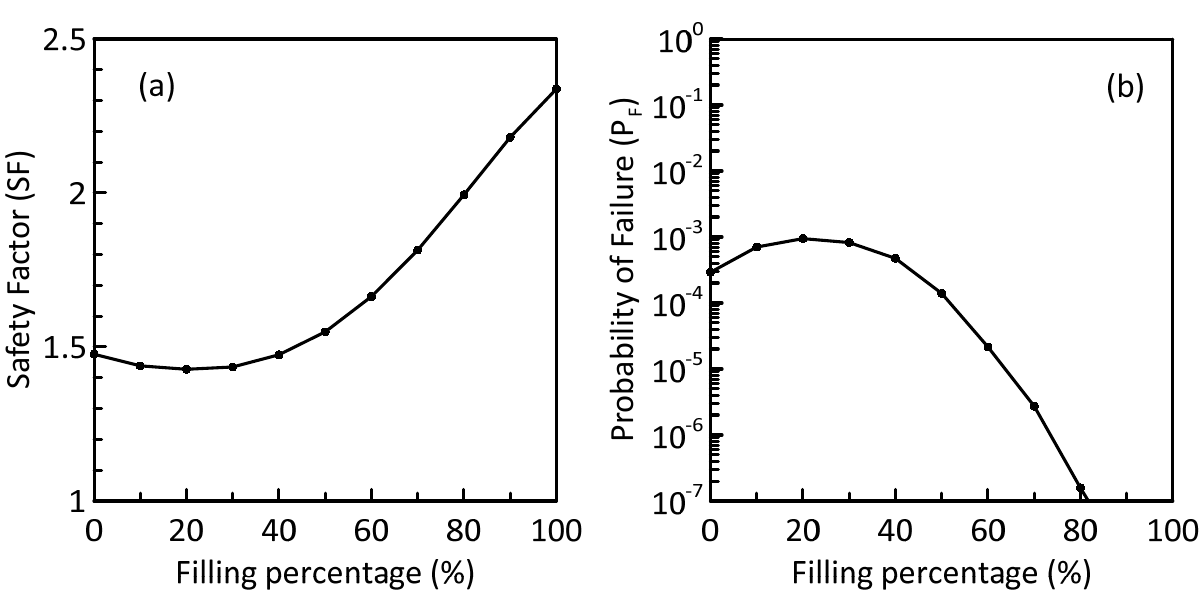
Figure 2. Evolution of ( a ) the safety factor and ( b ) the probability of failure with the filling percentage of a flooding open-pit.